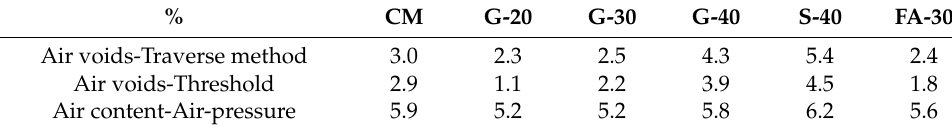
Table 6. Summary of air void content obtained with different methods.